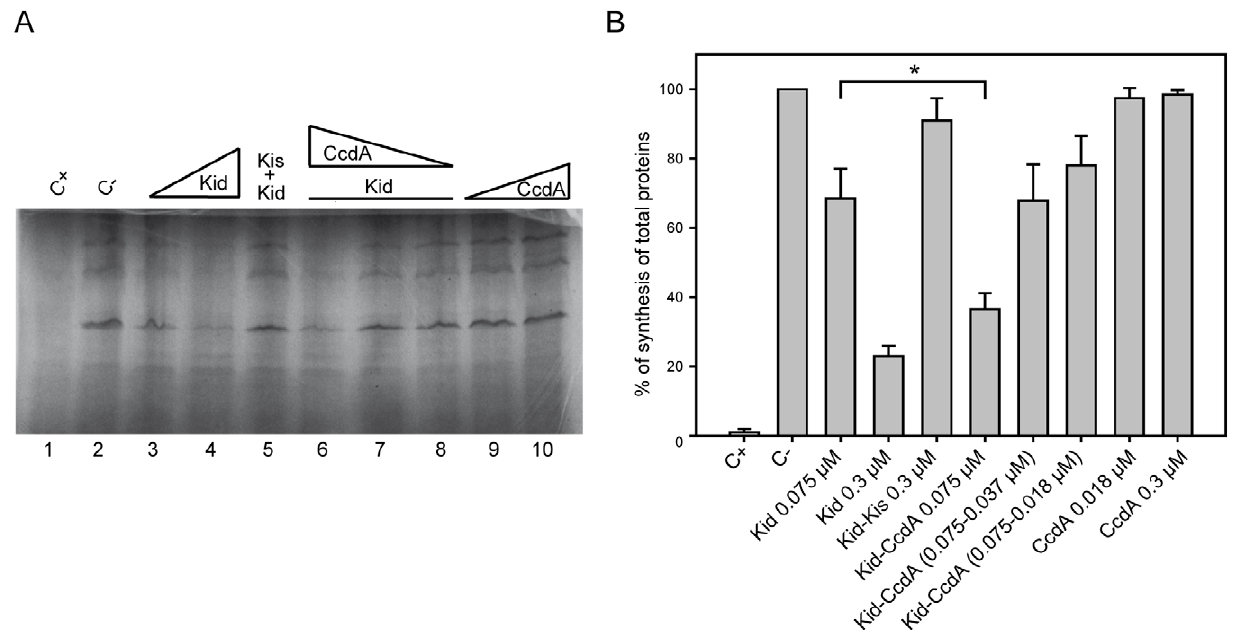
Figure 2. Effects of Kid/Kis and CcdB/A on protein synthesis in E.coli cell extracts. (A) Coupled transcription/translation assay with E. coli S30 extracts using a luciferase-encoding plasmid as template. 35 S-labelled products translated in the absence or presence of purified Kid, Kis, CcdB and CcdA proteins were analysed using 15% SDS-PAGE. Tracks: 1, C + control sample treated with chloramphenicol (30 m g/mL); 2, C 2 , assay run in the absence of toxin/antitoxin proteins; 3 and 4, effects of adding Kid (0.075, 0.3 m M); 5, neutralisation of Kid by Kis (0.3 m M each); 6, 7, 8, assays run in the presence of Kid (0.075 m M) and CcdA at 0.075, 0.037, 0.018 m M respectively; 9, 10, CcdA alone at 0.018, 0.075 m M. (B) Bar graph representation and quantitative analysis of data in (A). The signals of the labelled proteins were scanned and an integrated value calculated for each condition using a Quantity One informatics program. The percentage of synthesis of total proteins in each track was referred to the value obtained in the untreated sample. The bars above the different values represent the standard deviation calculated from three independent experiments. A Student’s t-test indicated that the differences between values in bars linked with a bracket were significant (p-value=0.0217). * Represents a p-value # 0.05.